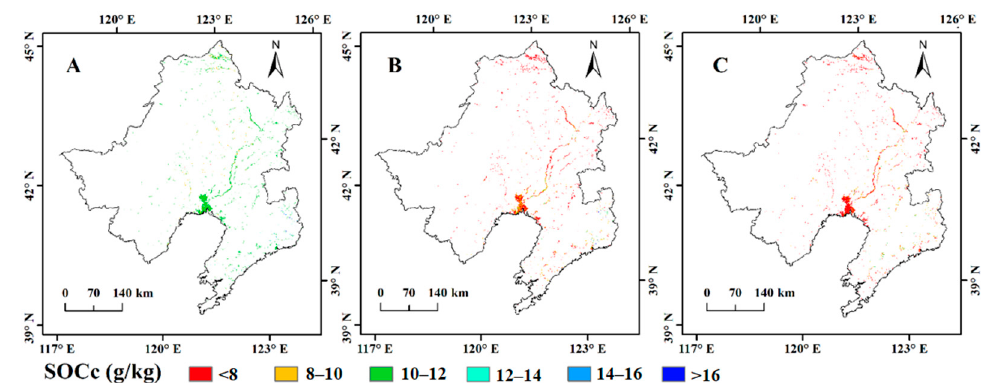
Figure 5. Spatial patterns of the predicted wetland soil organic carbon concentration (SOCc) at different depths: ( A ) 0–30, ( B ) 30–60, and ( C ) 60–100 cm.